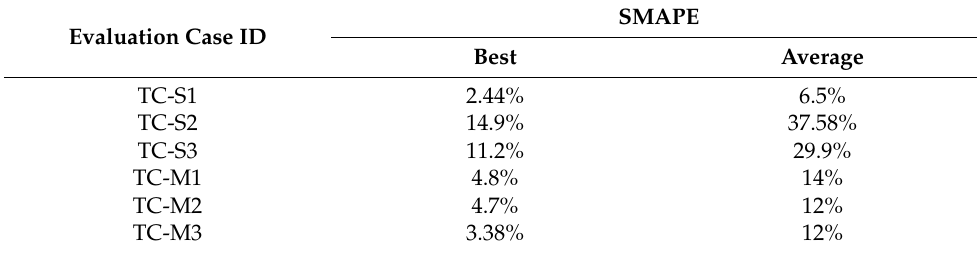
Table 2. Energy prediction